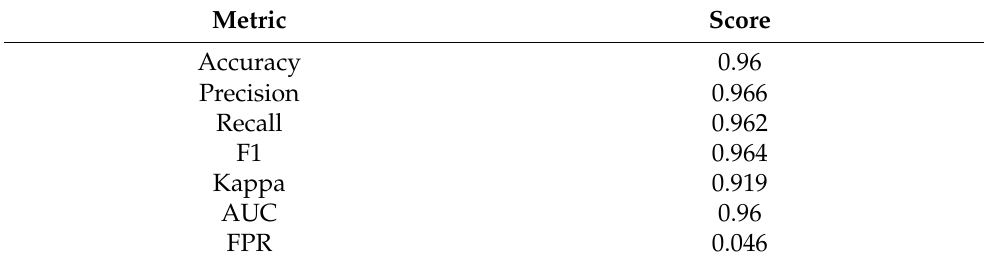
Table 9. Average metric values analyzed between May and September.